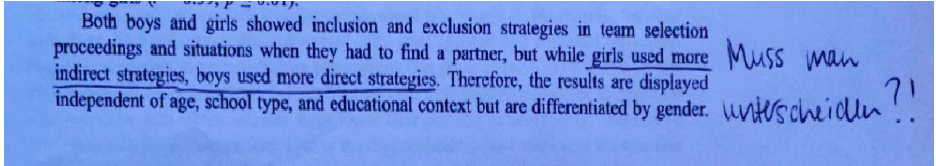
Figure 8. Annotating as rejoinder (Reprinted from Grimminger 2014, p. 162).